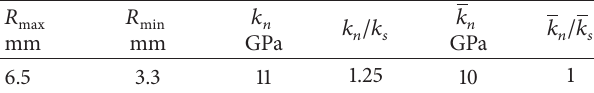
Table 1: Values of microparameters of granular